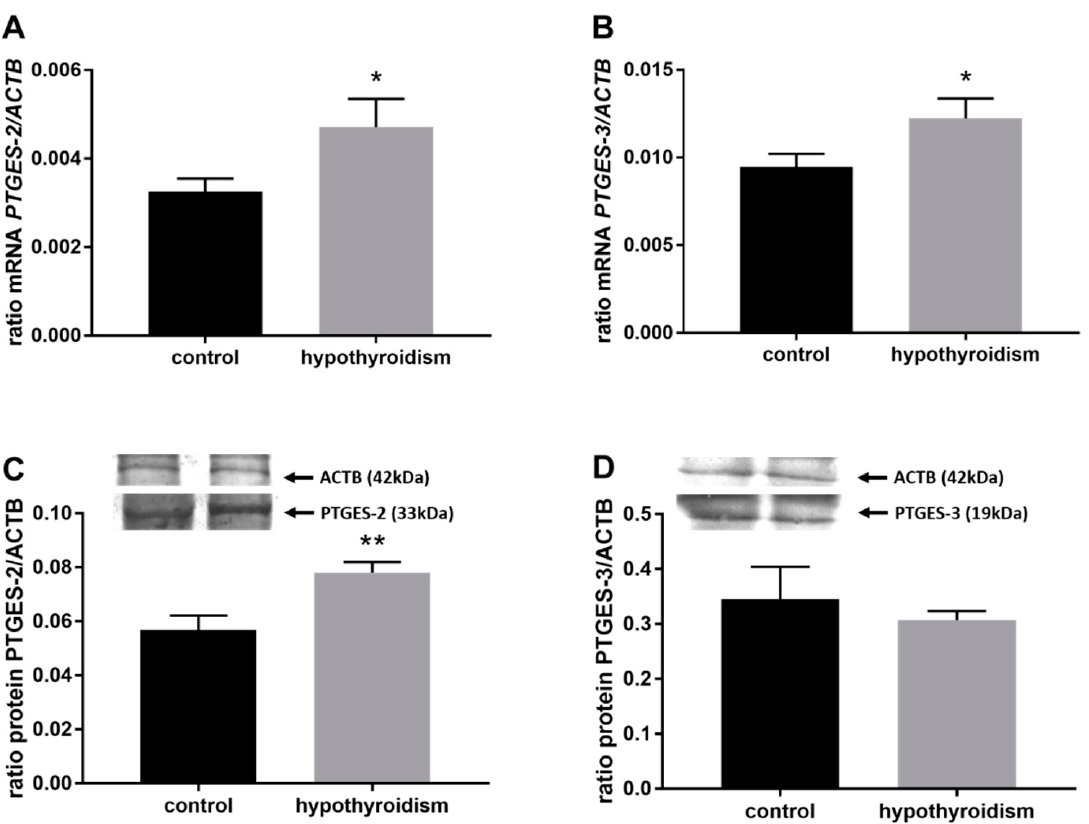
Figure 5. The effects of hypothyroidism on the mRNA and protein abundance of PGE 2 synthase 2 in the uterine tissue of rats: ( A , C ): PTGES-2/PTGES-2; ( B , D ): PTGES-3/PTGES-3. The values are presented in arbitrary units and expressed as the mean ± SEM. Stars indicate significant differences (* p ≤ 0.05, ** p ≤ 0.01, *** p ≤ 0.001, **** p ≤ 0.0001), as determined by Student’s t -test.